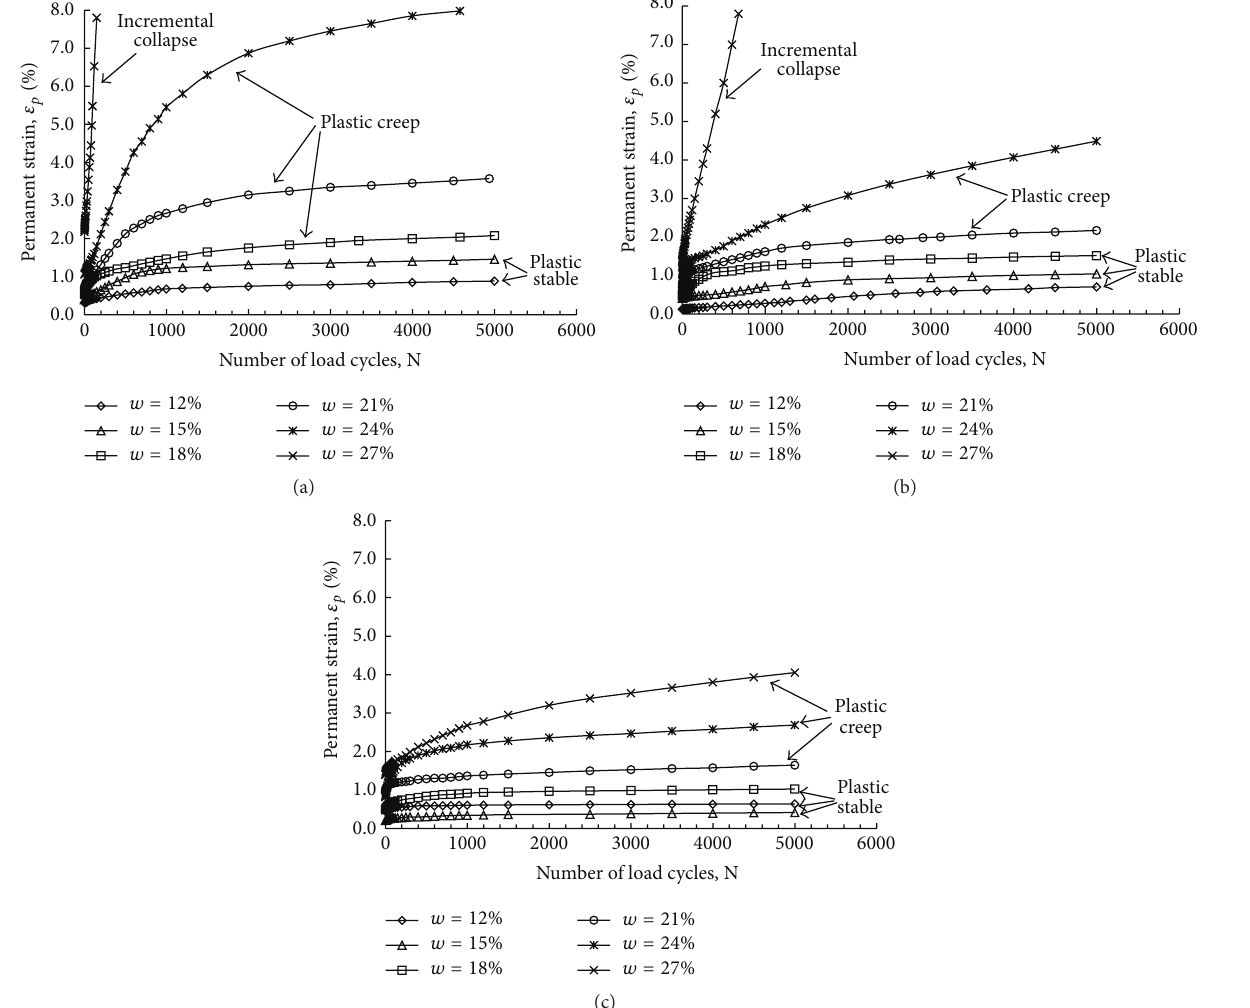
Figure 5: Permanent strain under a cyclic deviator load of 150N for various moisture contents and different degrees of compaction: (a) 𝑘 = 90 %; (b) 𝑘 = 93 %; (c) 𝑘 = 96 %.